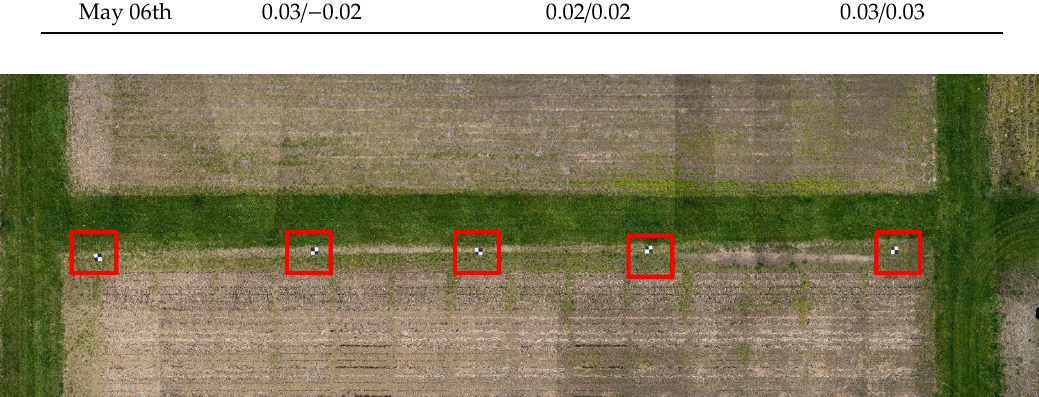
Figure 25. Orthophoto result from direct approach for Sony—May 06th data collection (red boxes show the location of the check points, 𝐺𝑆𝐷 ≈ 0.0056𝑚 ).